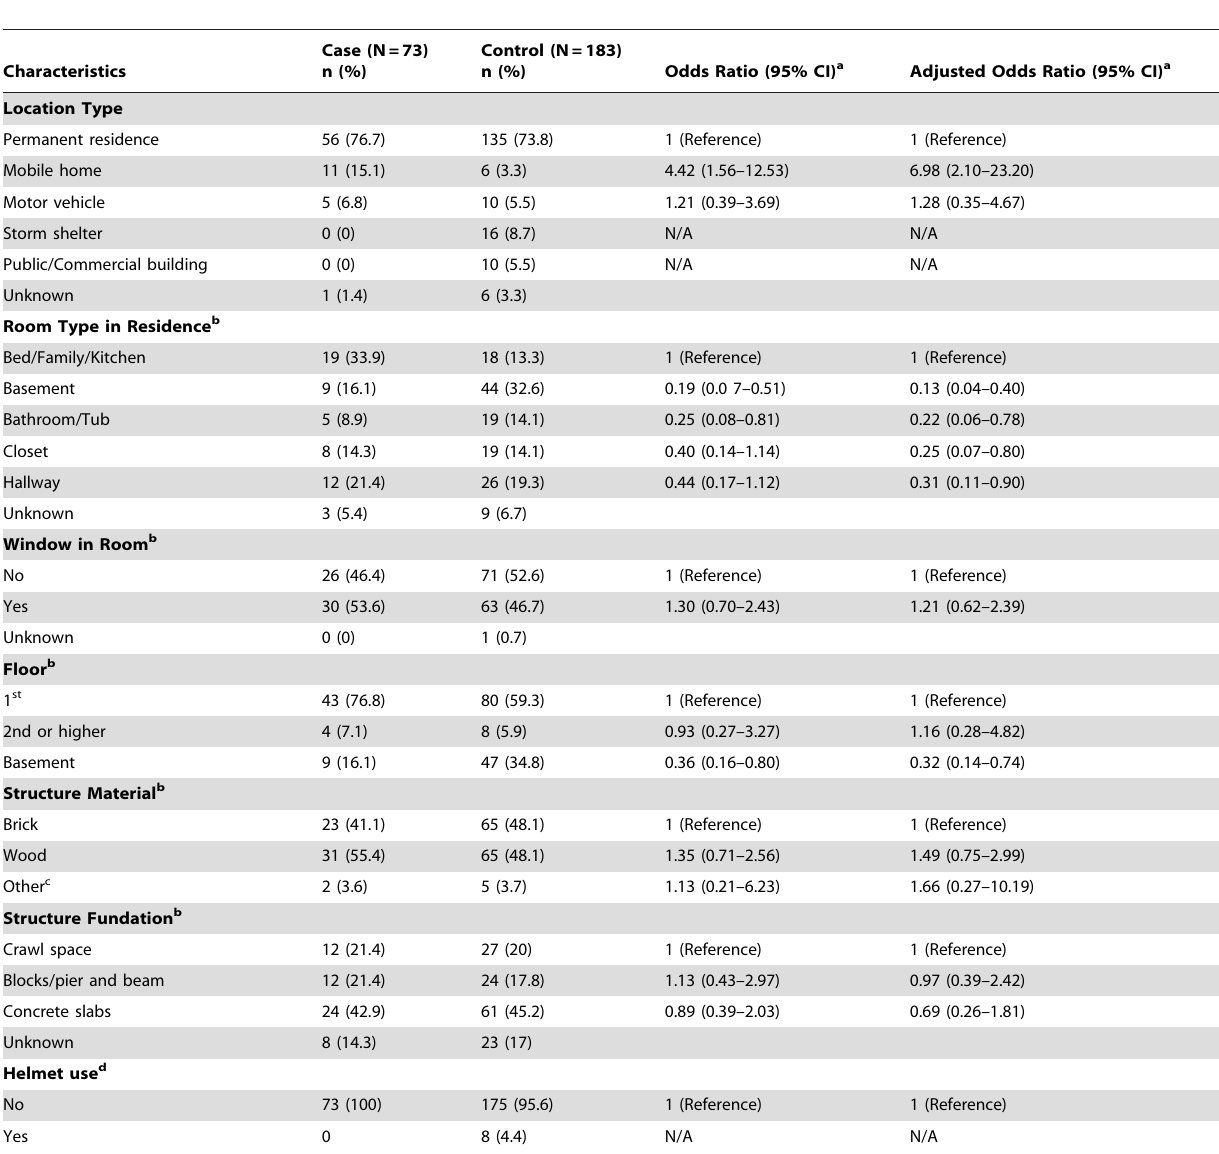
Table 3. Odds of injury associated with respondent’s location during the time of tornado impact among surveyed cases (N =73) and controls (N=183) with non-missing distance to the closest tornado